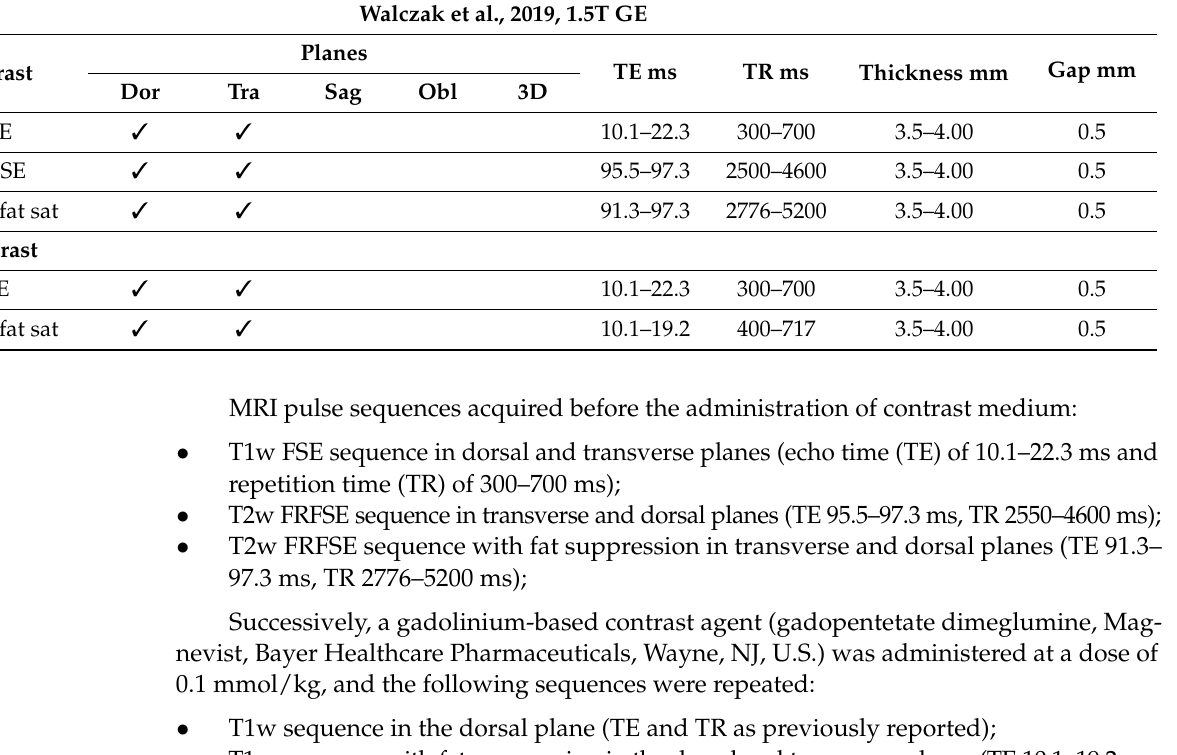
Table 2. MRI and MRCP protocols, including technical details used in Walczak et al., 2019. “Dor” stays for dorsal, “tra” for transverse, “sag” for sagittal, and “obl” for oblique. Walczak et al., 2019, 1.5T